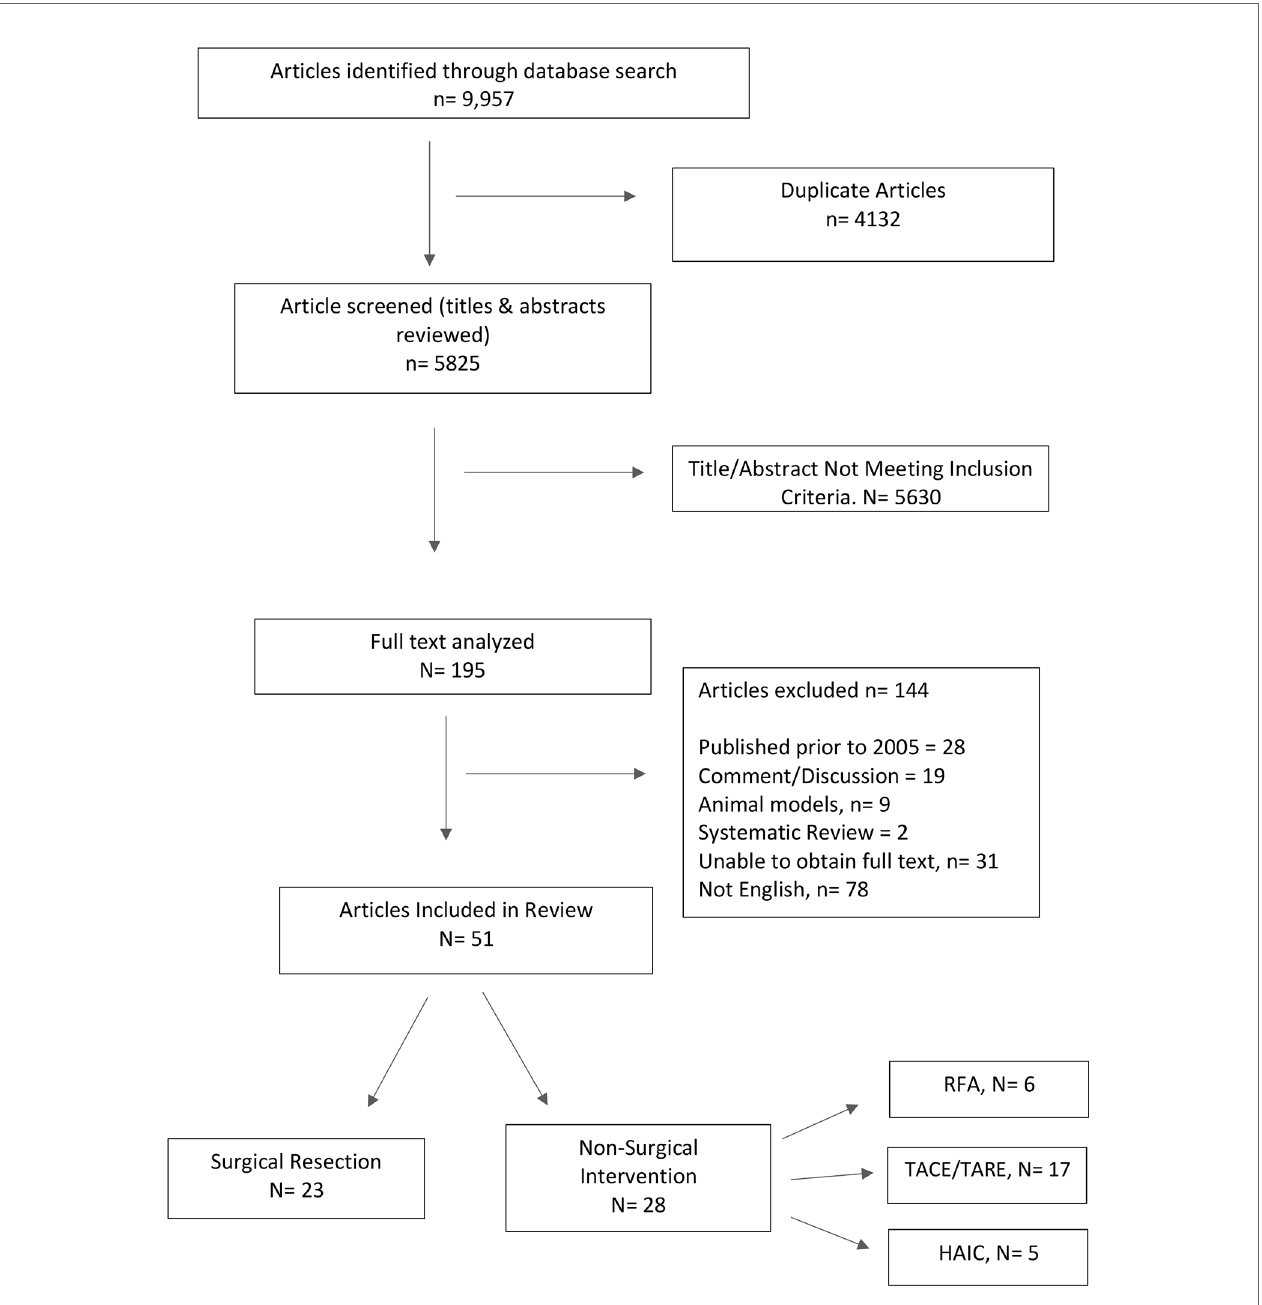
FIGURE 1 | PRISMA Flow